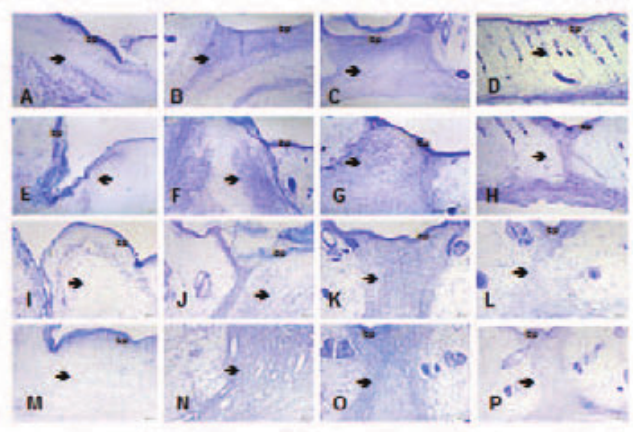
FIGURE 1 – Photomicrographs of cross-sections of wounds experimentally induced in Wistar rats. Group A, control ( A-D ); group B treated with microcurrent (10 μA/2 min/day) ( E-H ); group C treated with Jatropha curcas seed oil ( I-L ), and group D treated with Jatropha curcas seed oil and microcurrent (10 μA/2 min/day) ( M-P ). Tissue samples were collected on day 2 ( A, E, I and M ), day 6 ( B, F, J and N ), day 10 ( C , G, K and O ), and day 14 ( D , H, L and P ) after injury. The sections were stained with Toluidine blue. (Ep) Epithelium; (  ) repair area in the dermis. Bar = 100